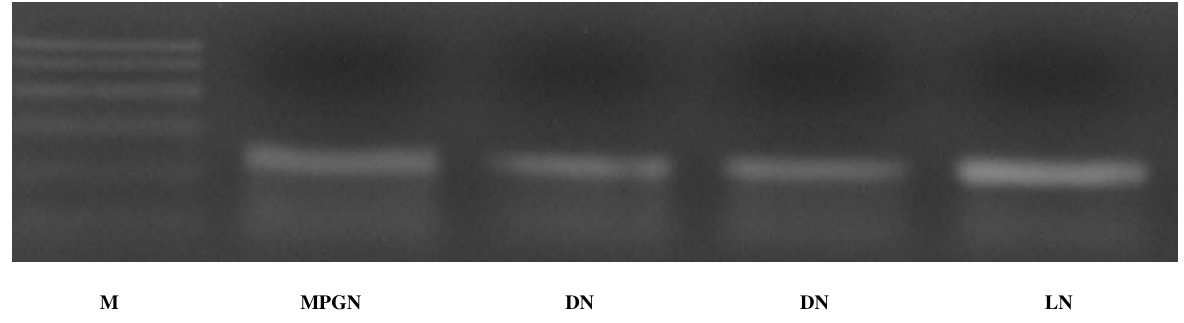
FIGURE 4. Ultraviolet transilluminated agarose gel electrophoresis shows PCR product of PKC β gene (254 bp) in different study groups (Lane M: PCR marker, Lane 2: MPGN case, Lanes 3 and 4: DN cases, Lane 5: LN case).